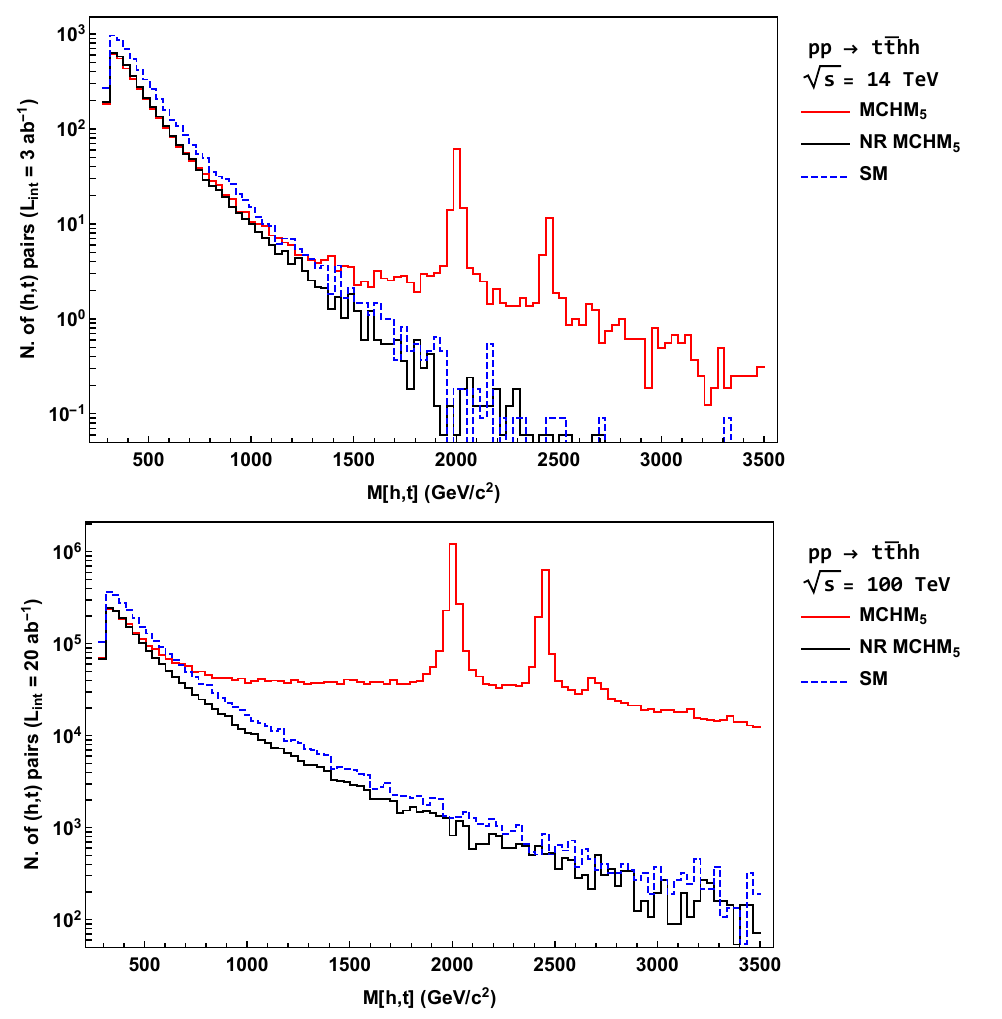
Figure 4 . Distribution of the invariant mass of the top quark and a Higgs boson in the MCHM 5 ( M 1 = − 2 . 5 TeV, M 4 = 2 . 0 TeV, f = 1 . 0 TeV, y L = 1 . 5 ). The red continuous line shows the distribution of the full tthh process in the MCHM 5 , while the NR- tthh cross section is shown in black. For comparison, we also show in dashed blue the SM tthh distribution. The upper (lower) plot corresponds to 14 TeV ( 100 TeV) CM energy. Histograms generated with MadAnalysis 5